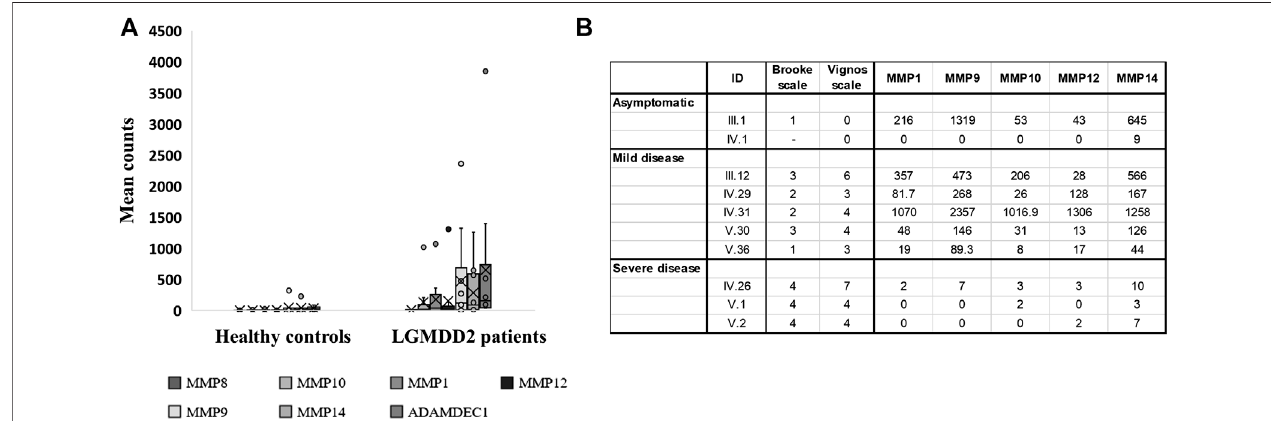
FIGURE 3 | Transcripts per million of reads obtained in the RNA-Seq experiment for differentially expressed genes encoding metallopeptidases. Dashes inside boxes indicated the median value and crosses indicated the arithmetic mean. Box limits indicate the interquartile range (IQR). Whiskers are adjusted to maximal and minimal values if lower than 1.5 times the IQR. Further outliers are indicated as circles (A) . RNA-Seq results expressed in transcripts per million reads obtained for LGMDD2 patient according to their severity (B) .